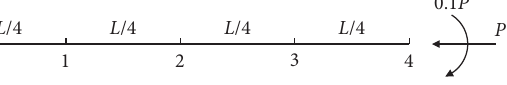
Figure 17: Piecewise points of steel